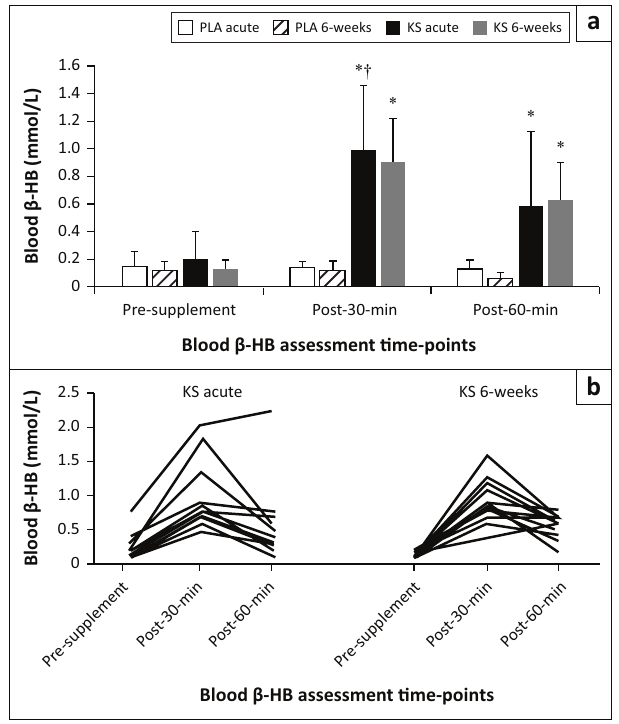
Values for graph (a) represent the mean ± standard deviation. * , p < 0.05 versus pre- supplement; † , p < 0.05 versus post-60-min. KS, ketone salt. FIGURE 3: Mean (a) and individual (b) blood ketone levels (β-HB) were greater 30 min (post-30-min) and 60 min (post-60-min) after consuming ketone salts than immediately before consuming them (pre-supplement). This occurred after consuming only one dose (KS acute) of KS and after regularly consuming KS for 6 weeks (KS 6 weeks).